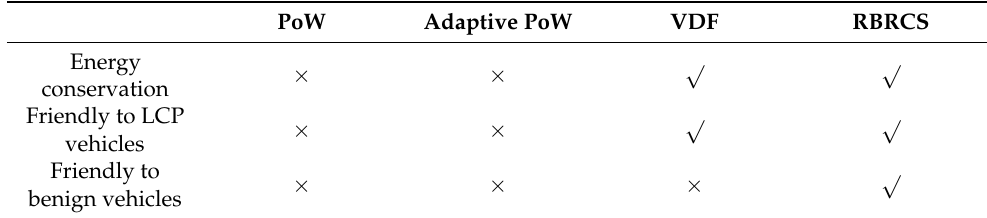
Table 4. Rate Control Strategy.